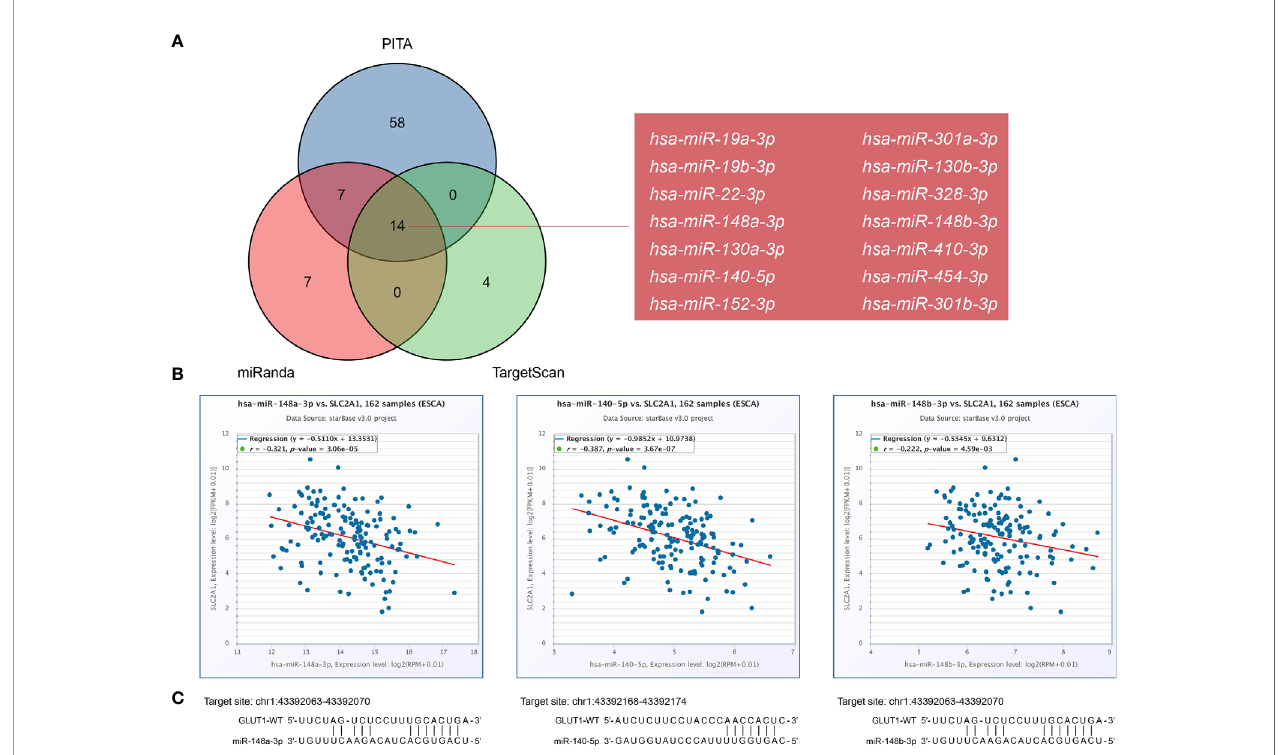
FIGURE 5 | Prediction of miRNAs targeting GLUT1 in esophageal carcinoma (ESCA). (A) Venn graph showing the prediction results of GLUT1 targets in PITA, miRanda, and TargetScan software packages. (B) Use starBase software to analyze the correlation between GLUT1 and the target miRNA. Use scatter plots to show miRNA-mRNA with signi fi cant correlation. (C) TargetScan predicts the potential binding site of GLUT1 to the target